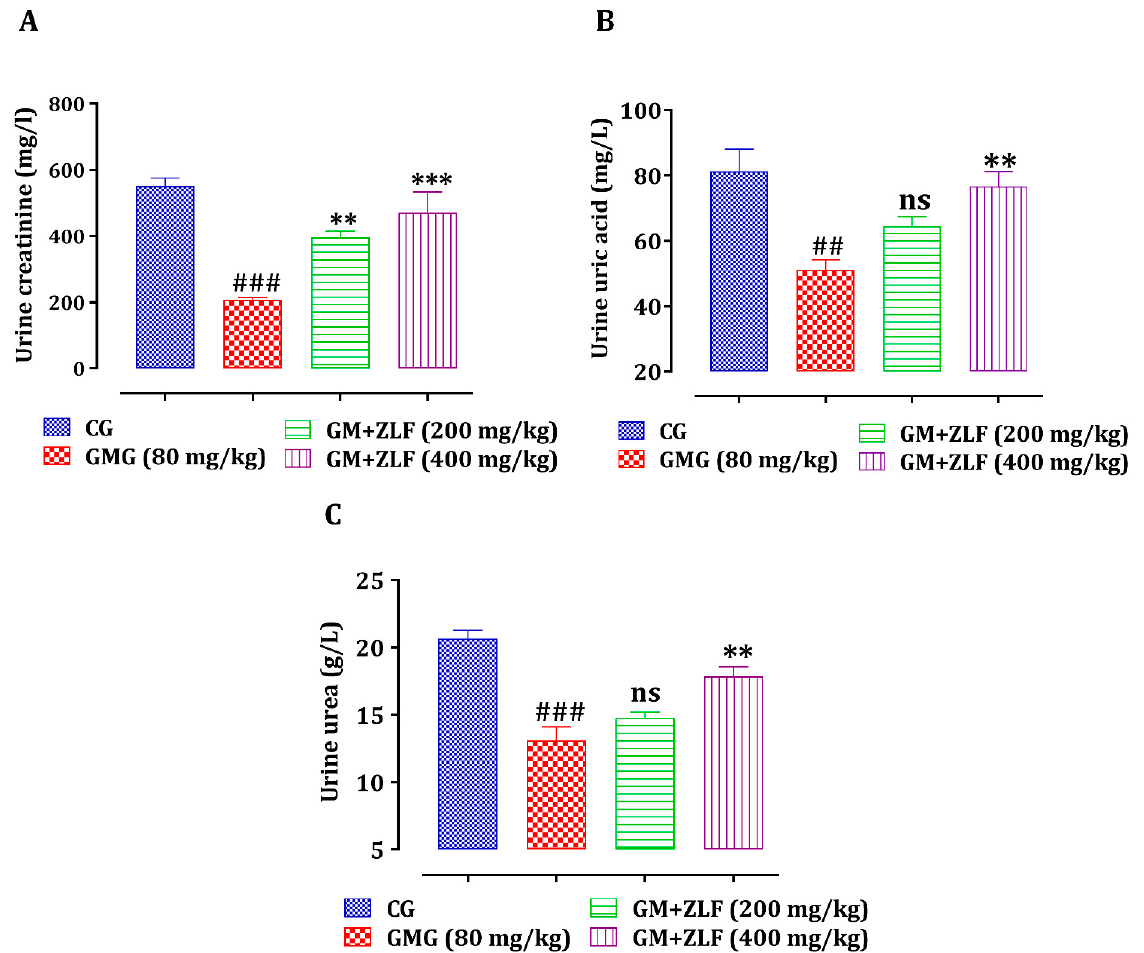
Figure 4. Effect of ZLF’s extract on urine creatinine ( A ), urea ( B ), and uric acid ( C ) in GM-poisoned rats. The data are presented as mean ± SEM, ( n = 6). ### p ≤ 0.001, ## p ≤ 0.01 versus CG. ** p < 0.01, *** p < 0.001 versus GMG. ns: not significant versus GMG. GM: gentamicin; CG: Control Group; GMG: GM treated Group.